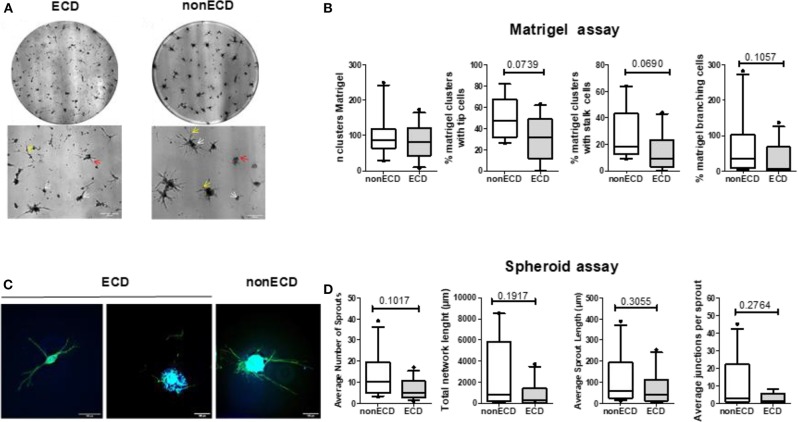
(A) Representative experiment of capillary tube formation by SVF from ECD or non-ECD. A total of 20,000 cells/well were seeded on growth factor reduced Matrigel. Images were recorded at 72 h with a phase-contrast microscope. Original magnification x5; upper panel (scale bars, 300 μm) correspond to the total image of the well while the lower panels were zooms of previous images (scale bars, 200 μm). White arrows identify initial cell clustering; red arrows marked the tip cells while yellow arrows identified branching. (B) Quantitative analysis of number of clusters, percentage of clusters with tip and stalk cells, number of branching points. Data are expressed as means ± SEM of independent experiments performed in triplicate using PRAT-SVF obtained in 14 ECD and 10 non-ECD donors (C) Representative experiment of 3D in vitro angiogenic assay with collagen gel-embedded spheroids of SVF from ECD or non-ECD (original magnification x20; scale bars, 100 μm). Imaging of Vascular sprouts was obtained after merging of actin staining (phalloidin in green) and nuclei staining (DAPI, blue) as detailed in Supplementary Figure 2
(D) Quantitative analysis of number of sprouts, branch points, and total network length per spheroid as well as average sprout length was compared in PRAT-SVF from the ECD and non ECD donors. For each experiment, at least 10 spheroids were analyzed.